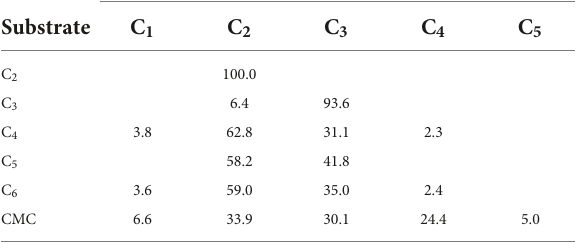
TABLE 4 Liquid chromatography analysis of the degradation products of cellulosic materials by recombinant endo- β -1,4-glucanase